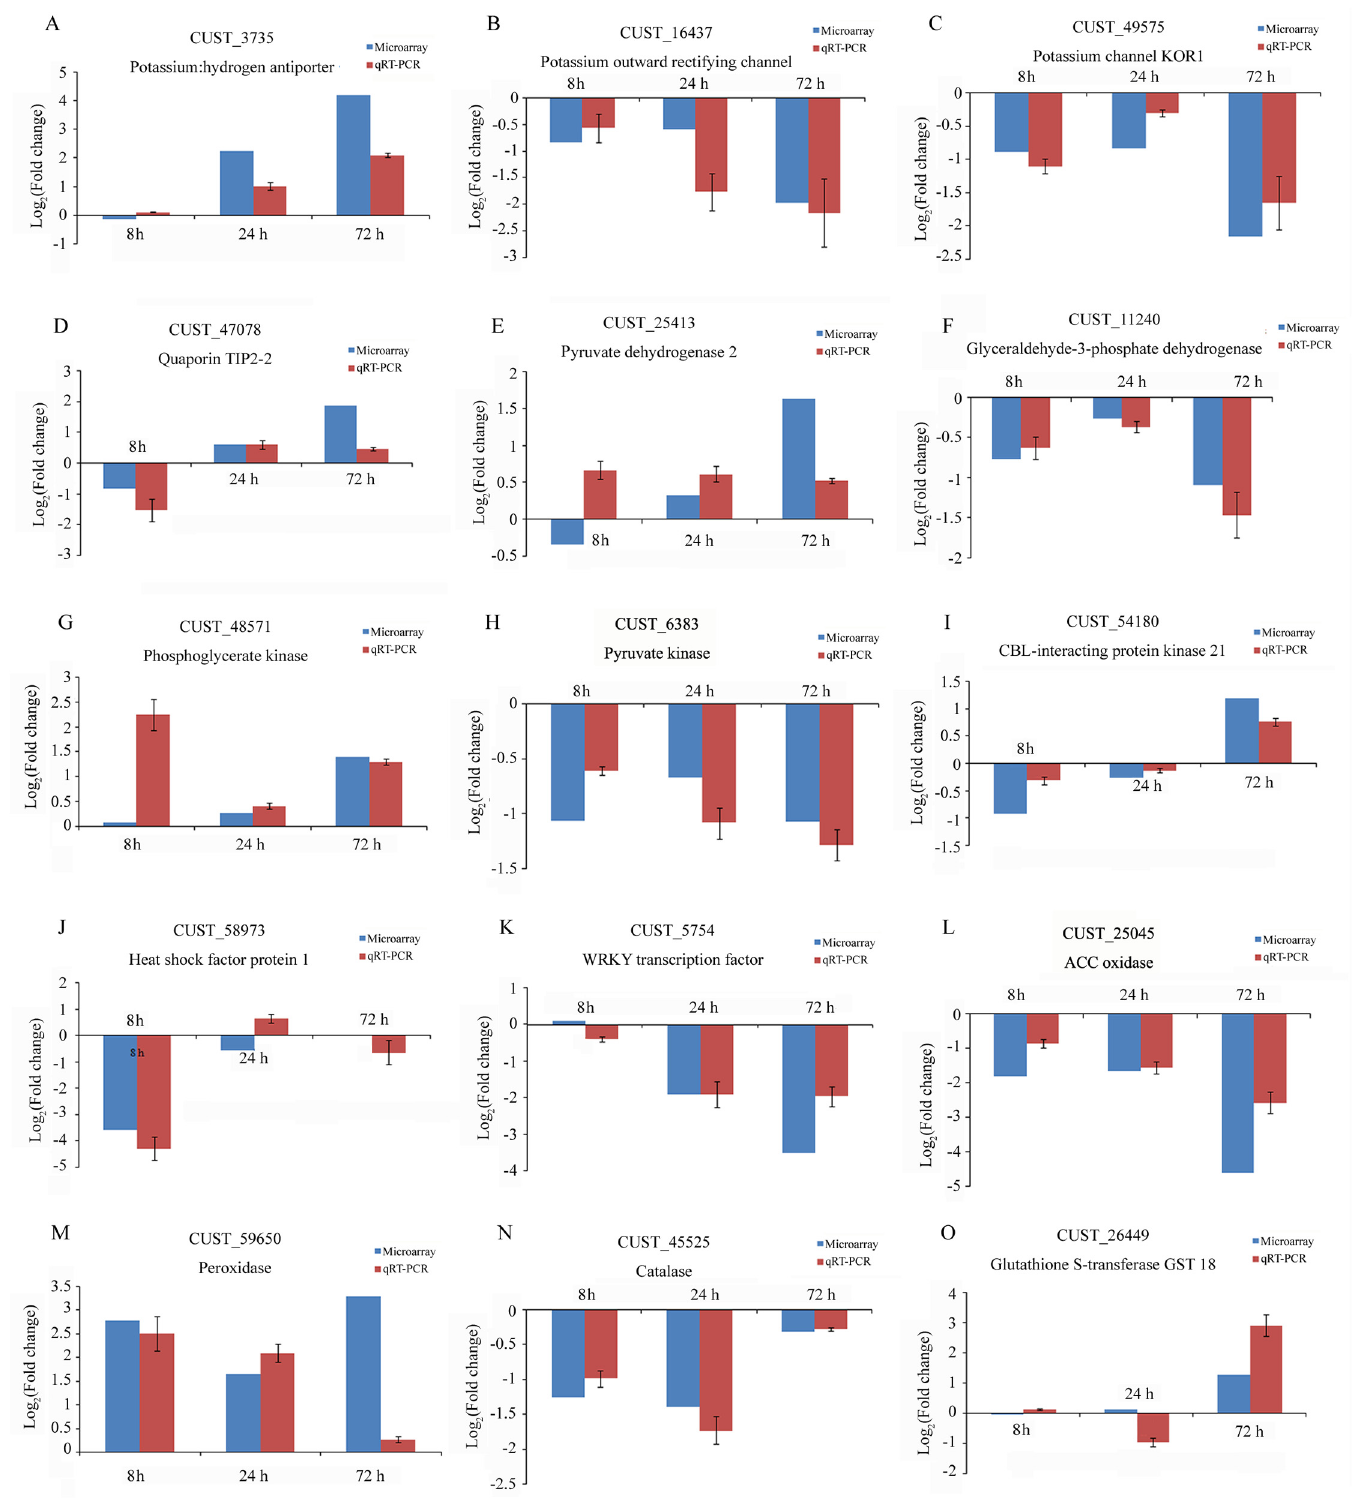
Fig 4. Quantitative real-time PCR confirmation of the transcriptomic profiles of selected genes. The log 2 (LK/CK) values derived from the microarray data of 15 genes were compared with those from qRT-PCR.